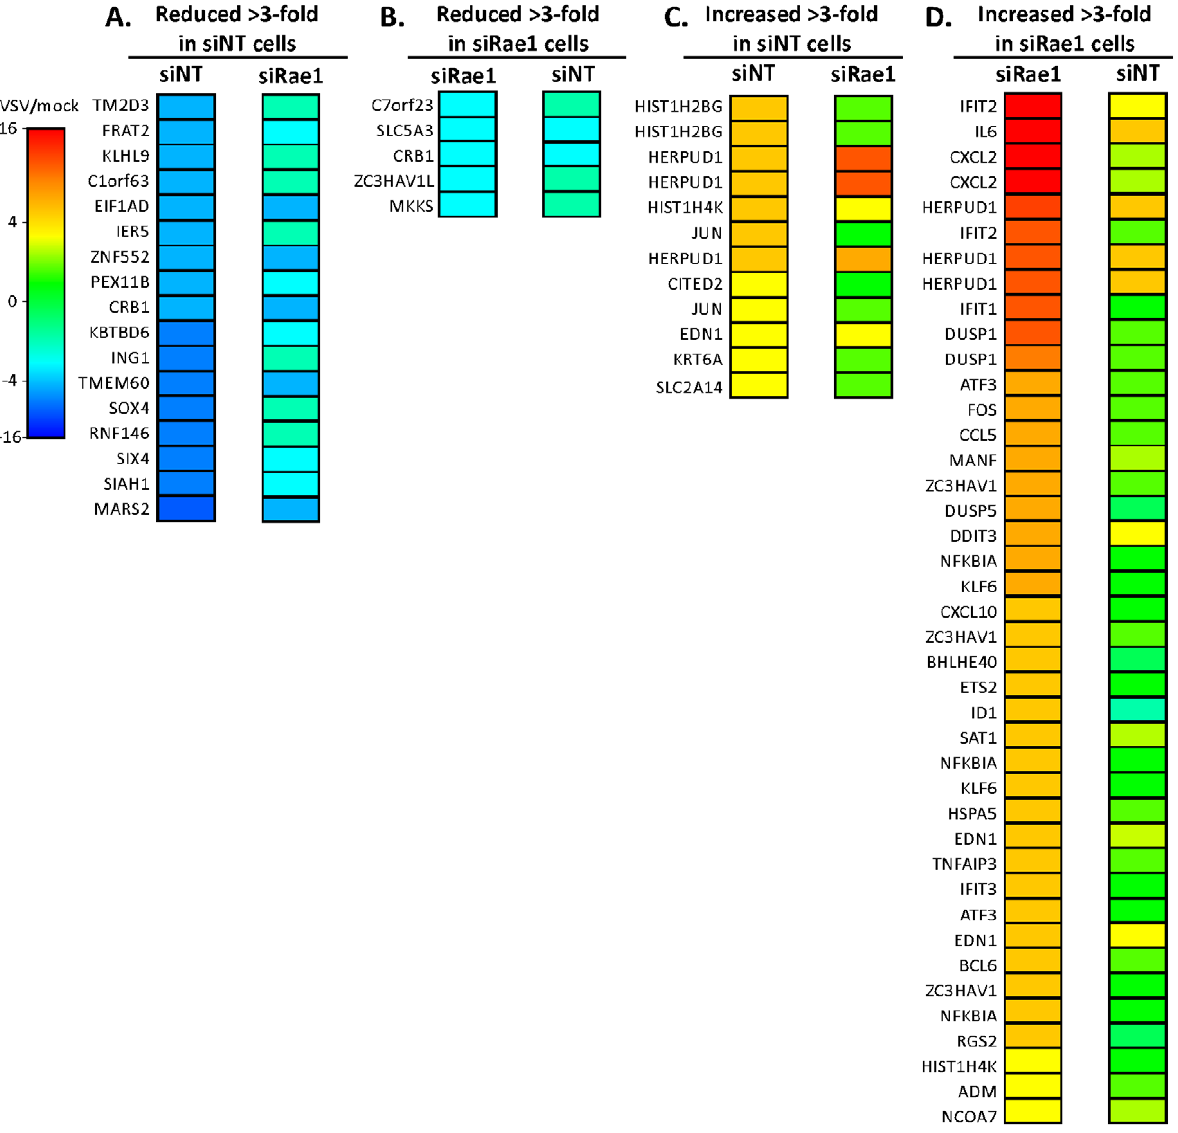
Figure 6. Effects of silencing the expression of Rae1 on mRNA expression in VSV-infected cells. Cells were transfected with Rae1 siRNA or NT siRNA, then mock-infected or infected with rwt virus. At 6 h postinfection, total RNA was isolated and analyzed using Affymetrix Human Genome U219 Array strips. Data shown are gene symbols of probe sets that were reproducibly decreased ( A and B ) or increased ( C and D ) by greater than 3-fold in VSV-infected versus mock-infected siNT cells ( A and C ) or siRae1 cells ( B and D ). The selection criteria were that the combined variance in the probe set in repeat experiments gave p , 0.005 to minimize the false discovery rate. The probe sets, definition of gene symbols, and numerical data are provided in Table